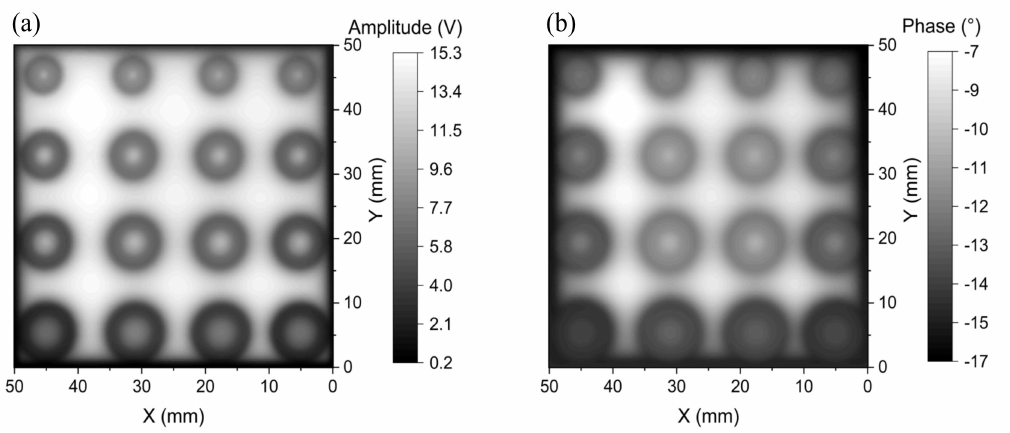
Figure 24. 2D images of ( a ) amplitude and ( b ) phase at the 60 kHz excitation frequency of the coil-based probe for detecting the surface flaws on the two-layer